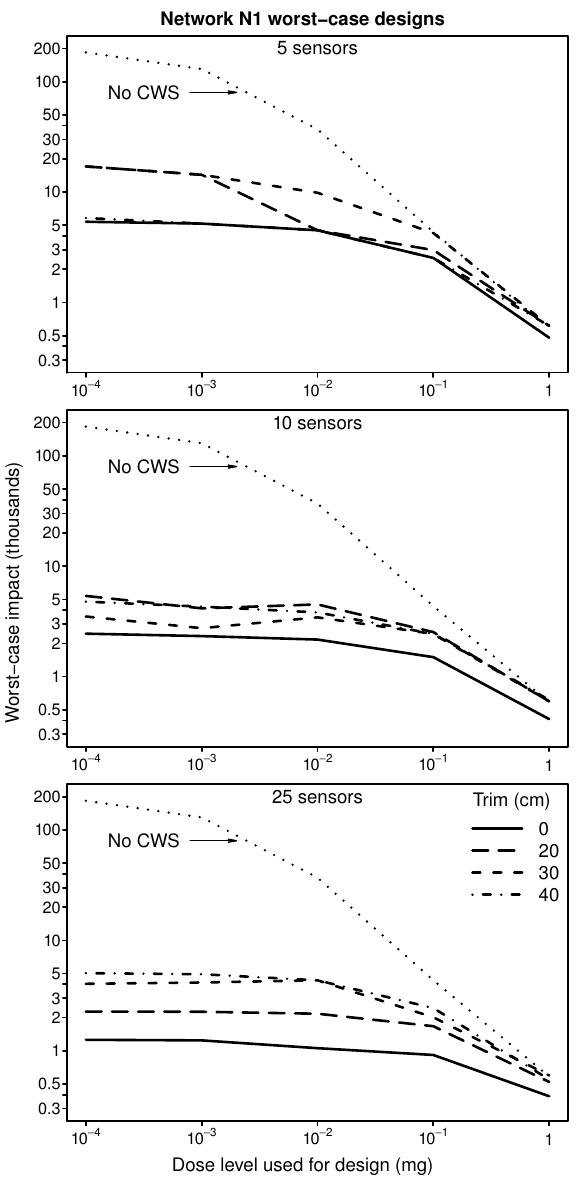
Figure 2. Worst-case impact versus dose level for original and transplanted worst-case CWS designs for Network N1. Results are shown for the original model and three levels of network skele- tonization